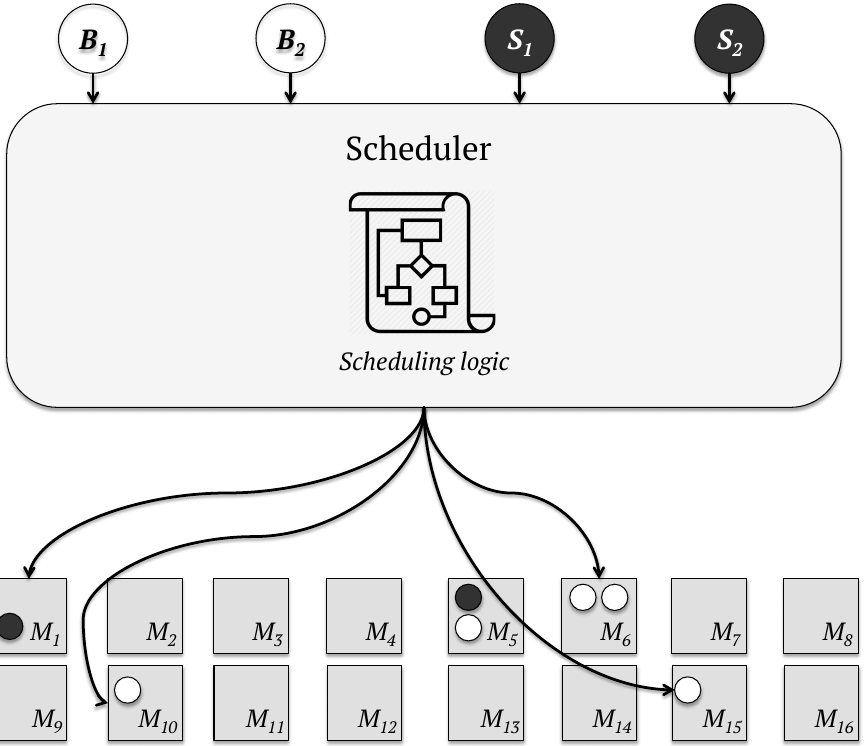
Figure 1. Monolithic scheduler architecture. M, worker node; S, service task; B, batch task